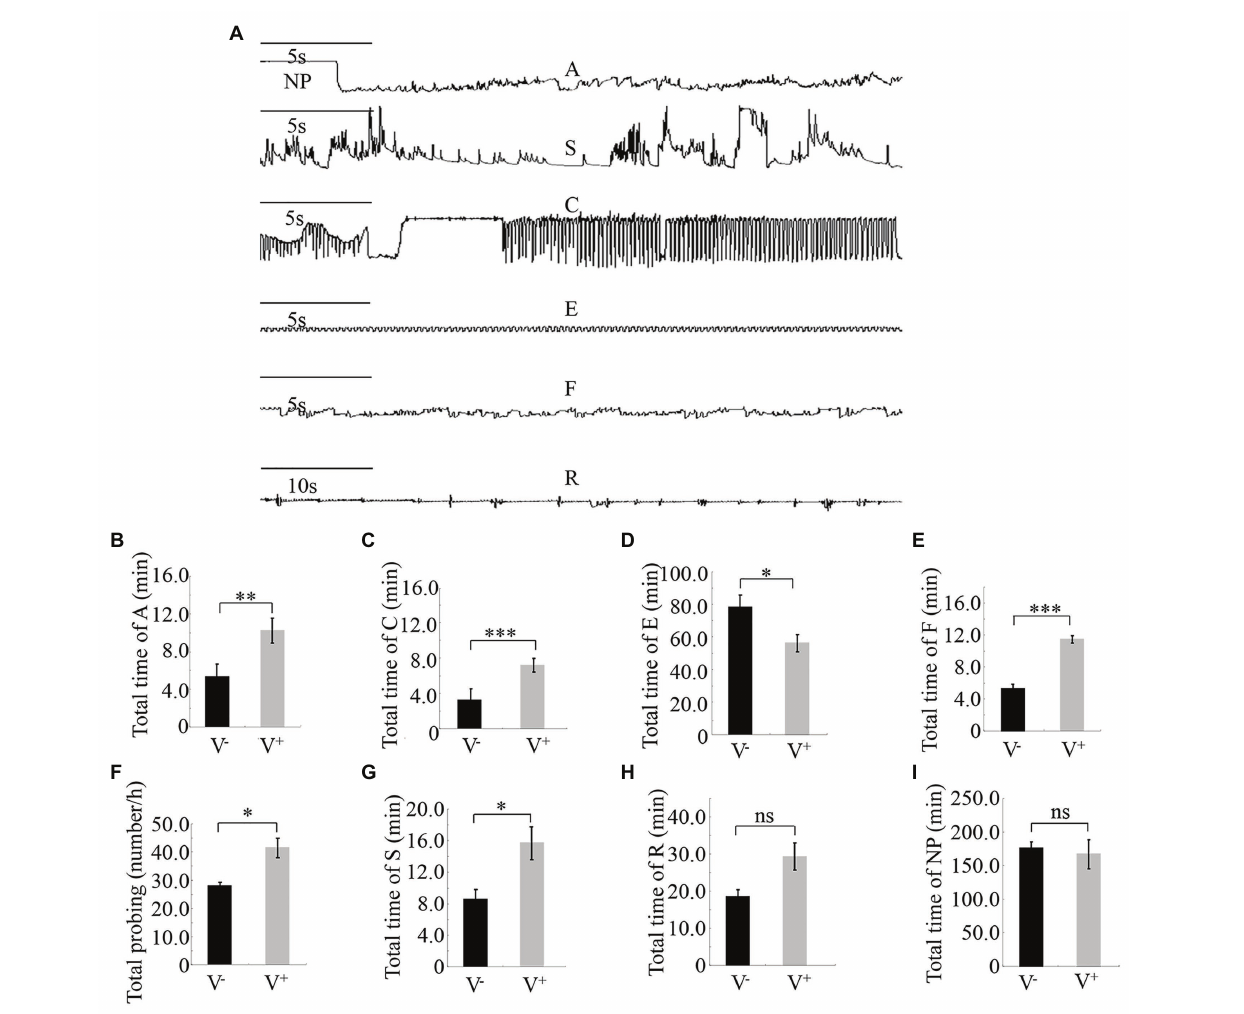
FIGURE 3 | Feeding behavior of viruliferous or nonviruliferous R. dorsalis on rice plants, as detected by electrical penetration graph (EPG) assay. (A) Characterization of the EPG waveforms produced by feeding R. dorsalis on rice plants, including waveforms NP, A, S, C, E, F, and R. NP, not probing. A, stylet movement in the tissue. S, intracellular salivation in mesophyll cells. C, active ingestion from the phloem. E, passive phloem sap ingestions. F, obstacle waveform. R, rest waveform. (B–I) Viral infection of insect vectors affected the feeding behavior of R. dorsalis . The data were electrically recorded during 5 h feeding period for viruliferous or nonviruliferous insects on healthy rice plants. V − , nonviruliferous adults feeding on healthy rice; V + , viruliferous adults feeding on healthy rice. Bars represent means ± SE. Significant differences in feeding behavior are denoted as *( p , 0.05), **( p , 0.01), or ***( p , 0.001); student’s t-test.